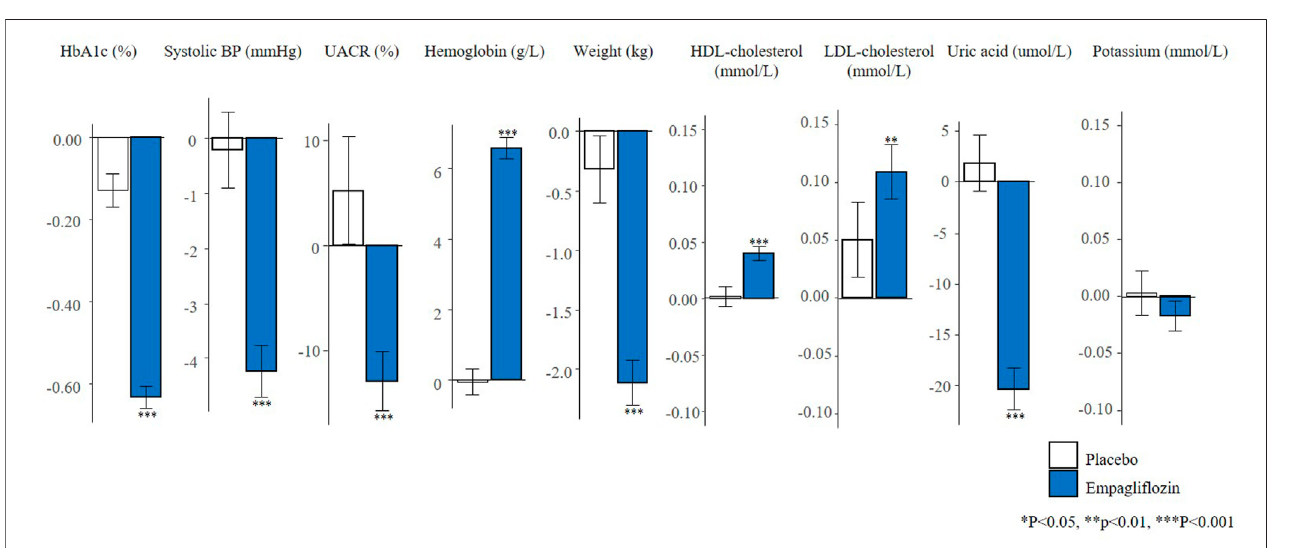
Frontiers in Pharmacology |